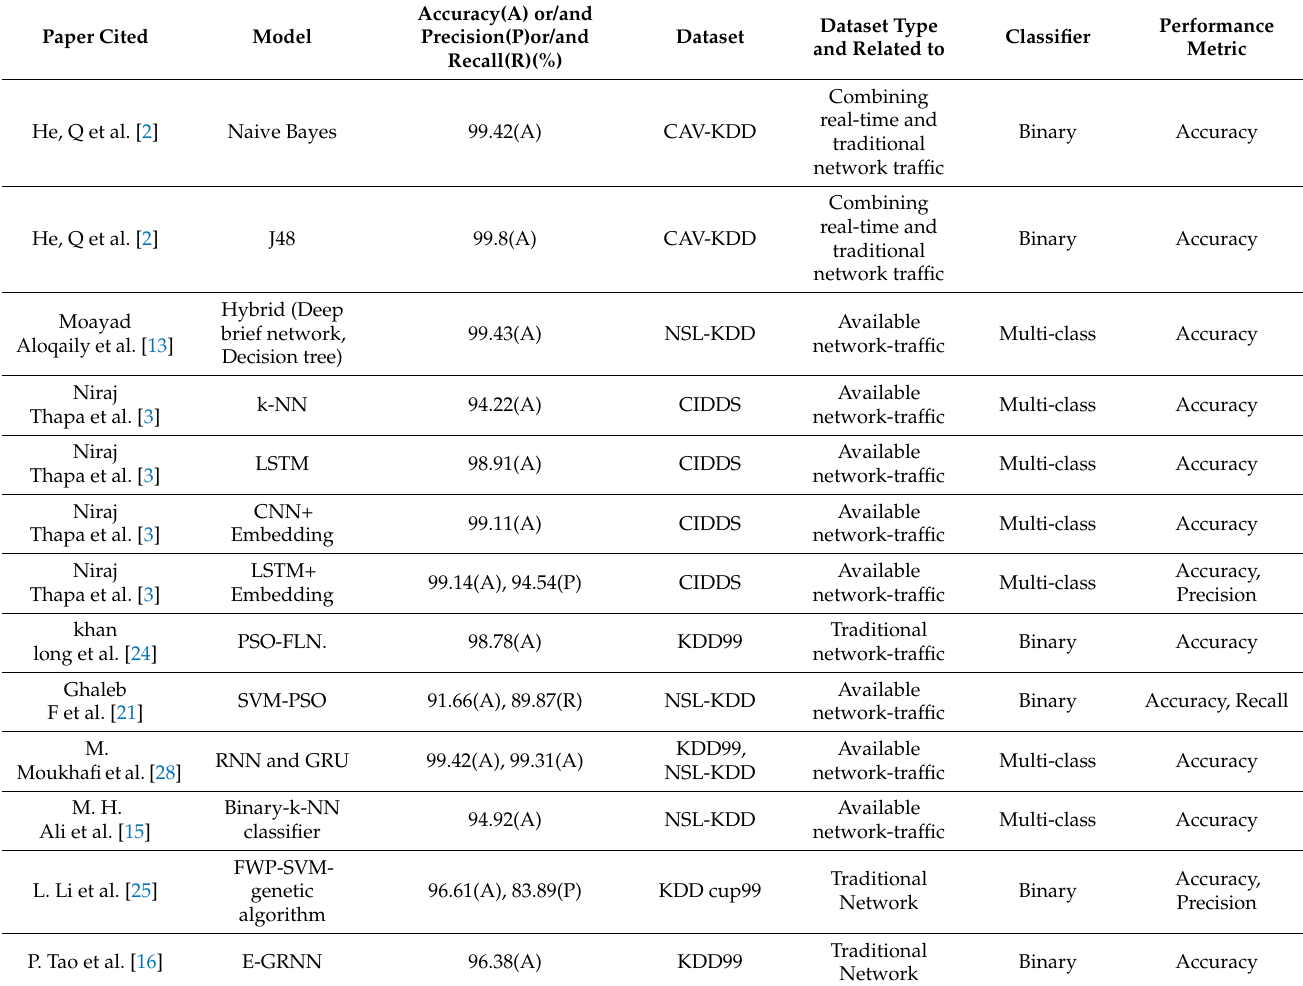
Table 4. Comparative performance of models discussed in the